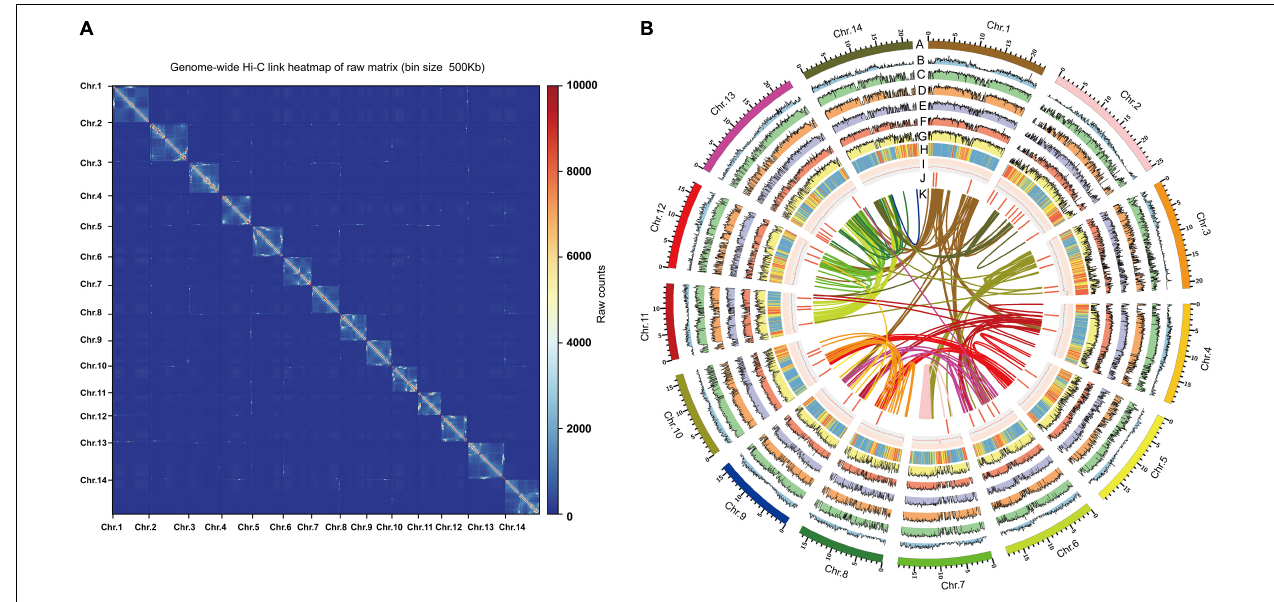
FIGURE 1 | Genome features of genome assembly of A. indica. (A) Hi-C contact data mapped on the A. indica genome showing genome-wide all- by-all interactions. (B) The landscape of genome assembly and annotation of A. indica . (A) Circular representation of the pseudomolecules. (B) The distribution of gene density with densities calculated in 500 kb windows. (C–G) Expression of A. indica genes (from outside to inside tracks: stem, root, leaf, fruit and flower). (H,I) The distribution of repeat density and GC density with densities calculated in 500 kb windows. (J) Locations of genes mapped to secondary metabolism. (K) Syntenic blocks.